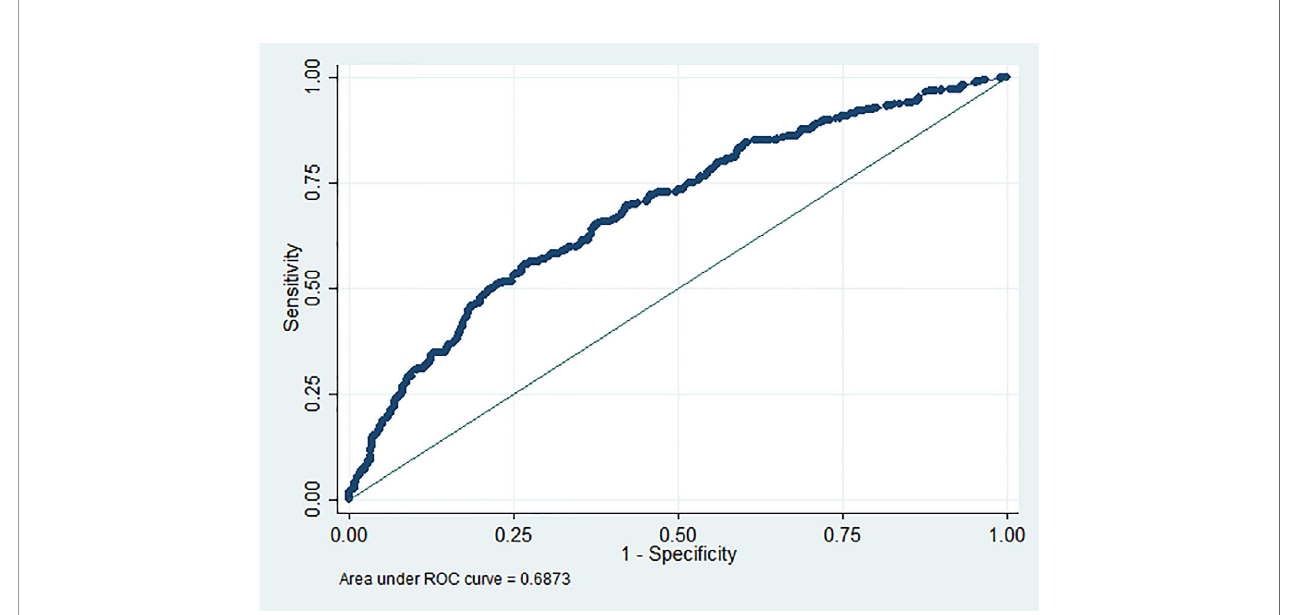
FIGURE 1 | Performance measure for predicting sleep disturbance using last fi tted multivariable logistic regression